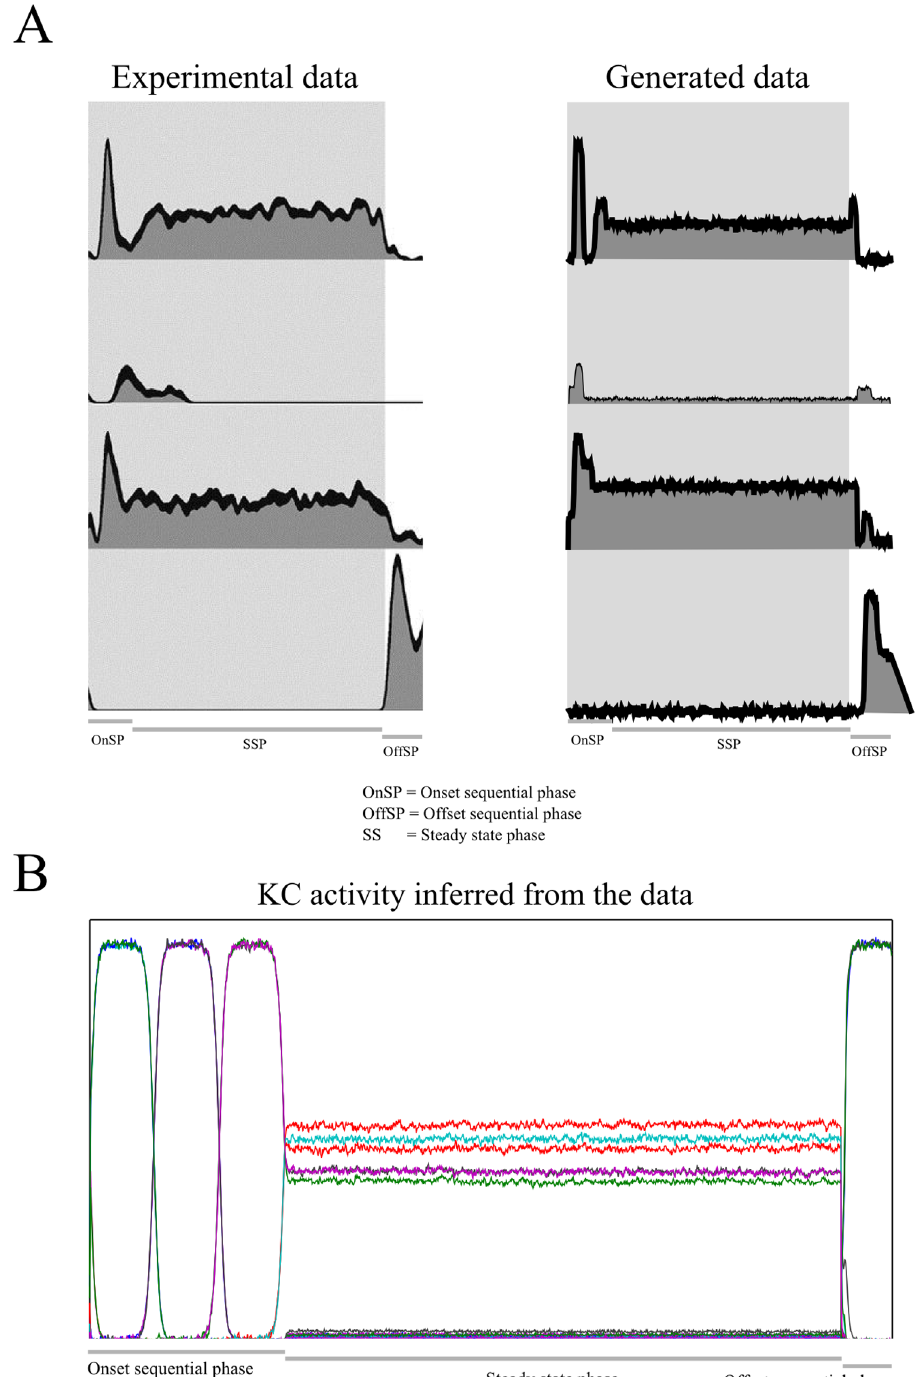
Fig 7. PN and KC activity for the full response to a stimulus. (A) Sample of four PNs ’ activity throughout the full response. Left: experimental data as reported in [7]; Right: data generated by our model. The qualitative behavior of the PNs observed in experiments can be matched by our model by choosing an appropriate observation matrix. (B) Bayesian inversion of the model: Inferred KC activity as a response to the PN data generated from the full response shown in A. Each color represents a cluster of three different KCs. It can be seen that the inferred KC activity displays the three phases of the odor response, although the generative model given by Eq 1 includes only the sequential